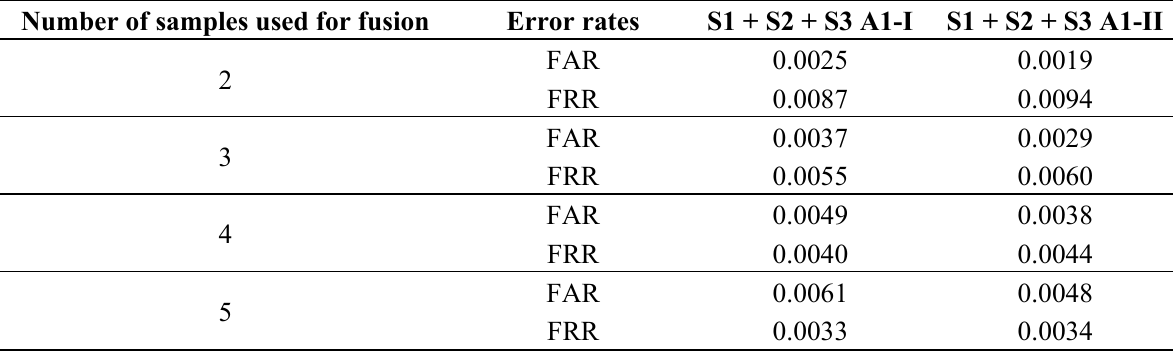
Table 8. Best performance (operation points closest to the performance target FRR ≤ 0.01 @ FAR = 0.001)—multi-sample-sensor fusion.